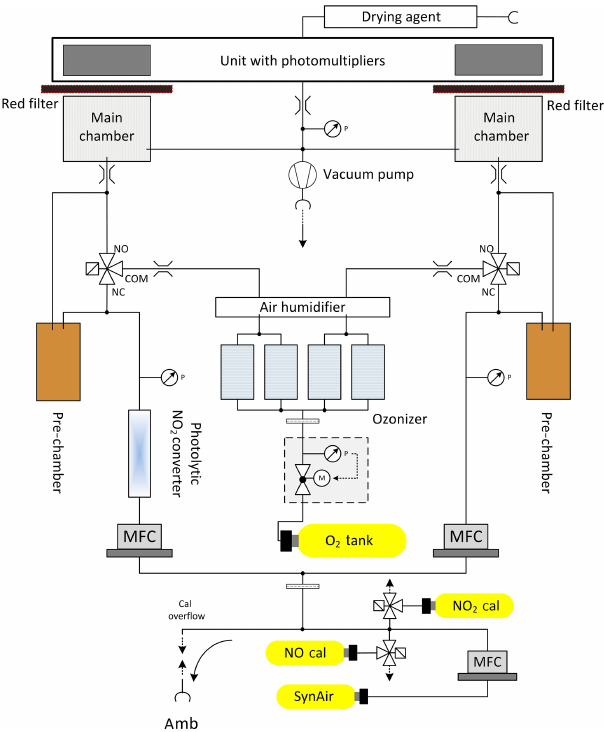
Figure 2. Schematic setup of the two channel CLD instrument in the configuration used during AQABA. NO and NO 2 calibration gases were running continuously and were added to the zero-air flow by switching the respective solenoid